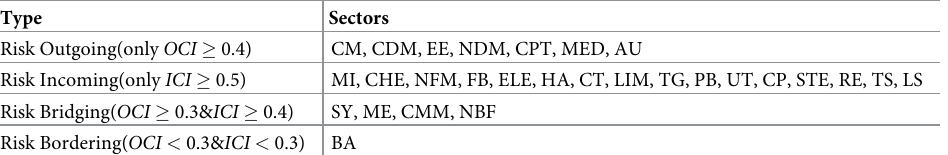
Table 3. Classification of nodes.